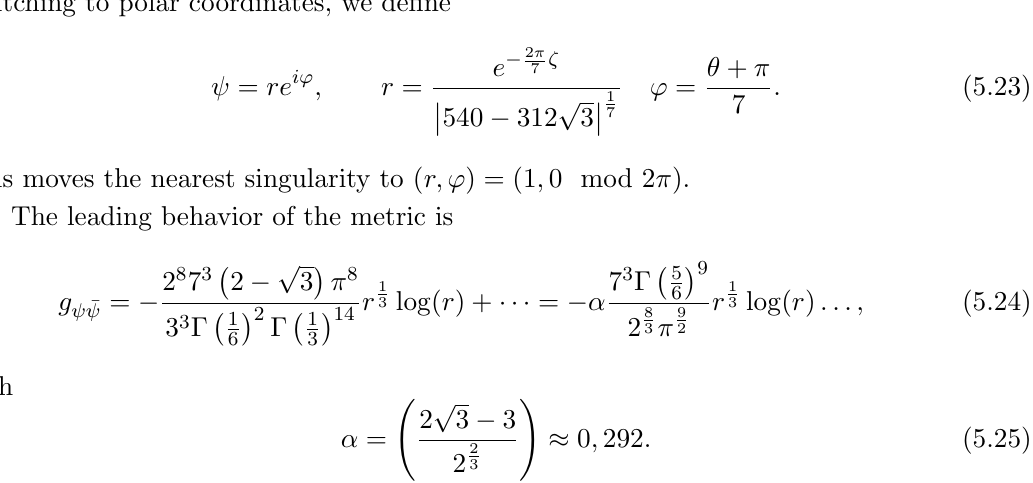
Figure 8 . Metric for the non-abelian model from the pseudo-point ( r = 0) to the nearest singularity ( r =